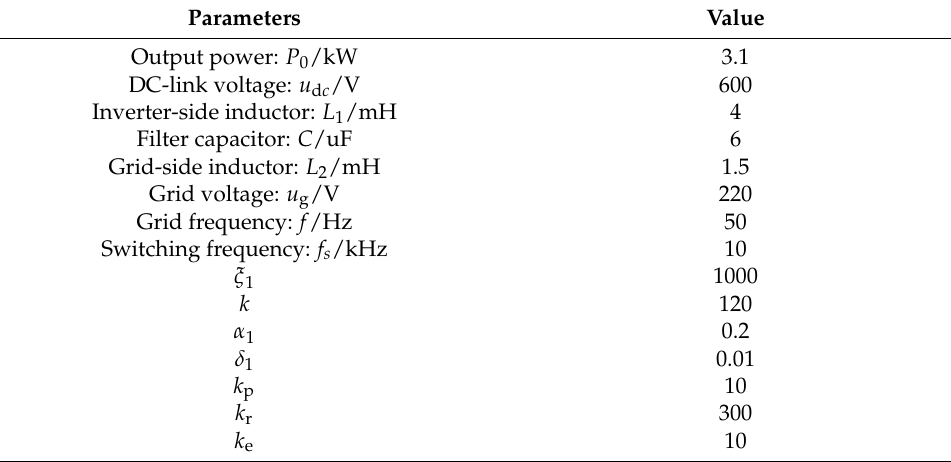
Figure 8. Fuzzy-ADRC module.